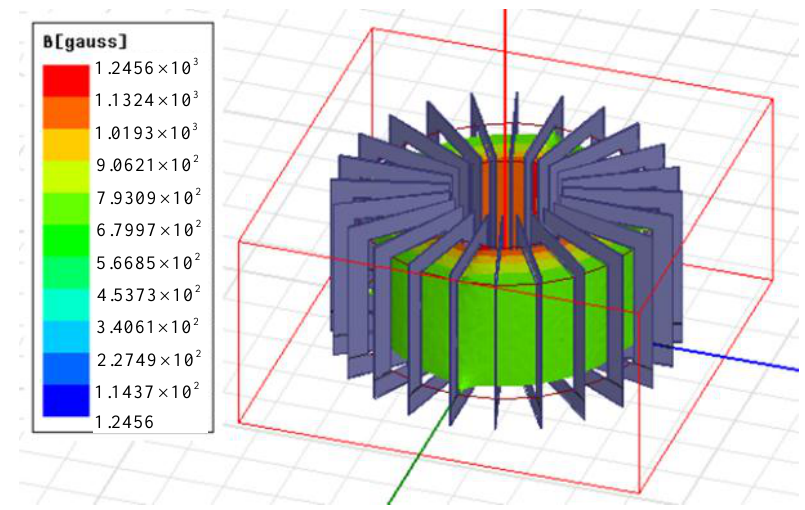
Figure 13. Simulating results of the magnetic flux density of the transformer with sendust ring-core.